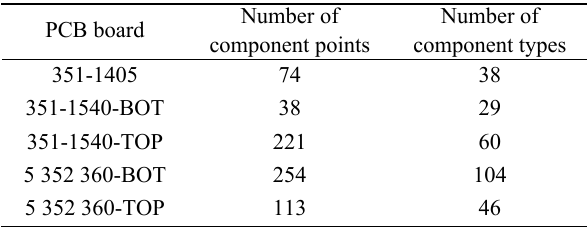
Table 1 Related data of the